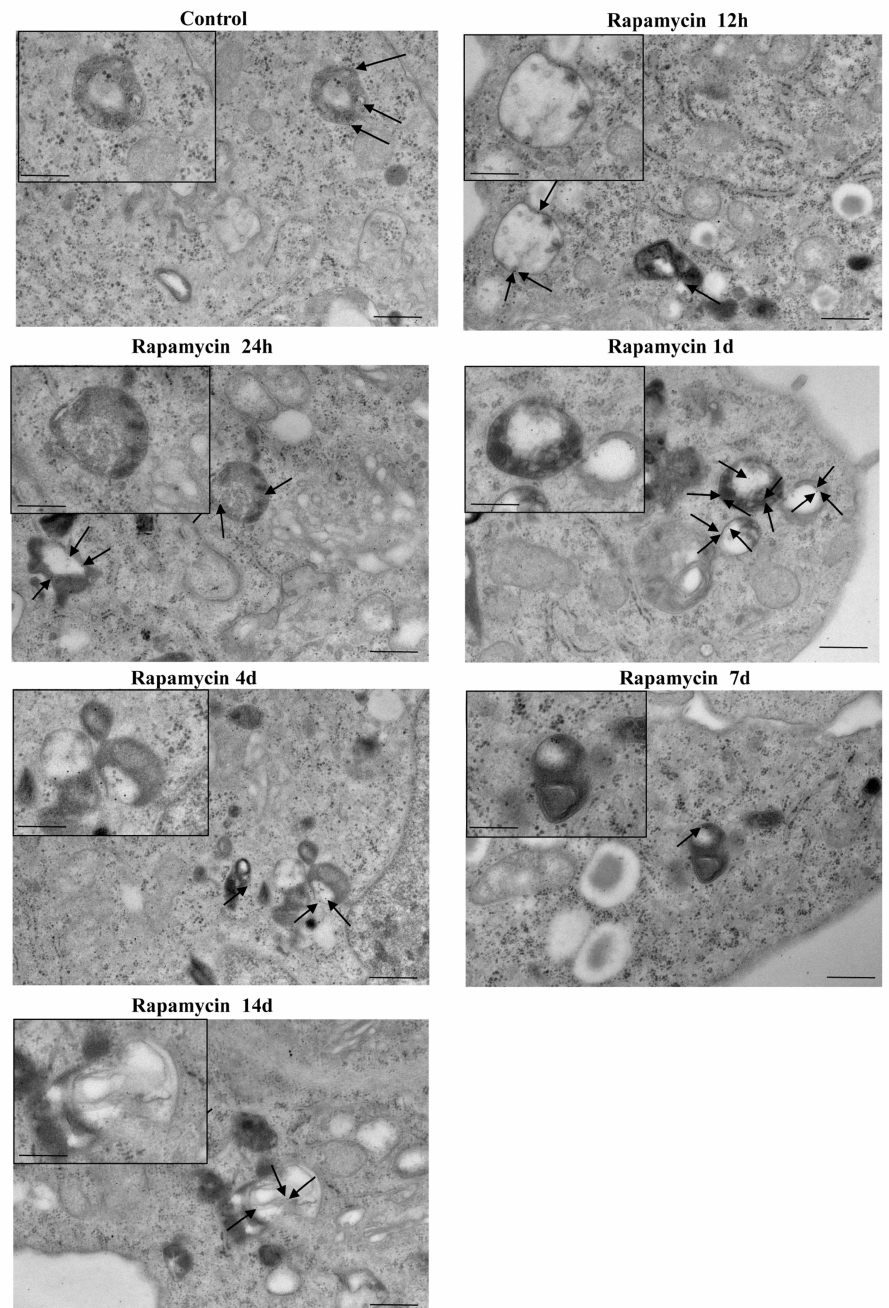
Figure 16. Representative pictures of rapamycin-induced LC3-stained and non-stained vacuoles within U87MG cells. The black box indicates high magnification inserts showing LC3-stained vacuoles. Black arrows point to LC3 immune-gold particles on vacuoles. Micrographs were obtained from 1 cell per group, for a total of 7 cells. Scale bar: 0.6 µ m (low magnification); 0.20 µ m (high